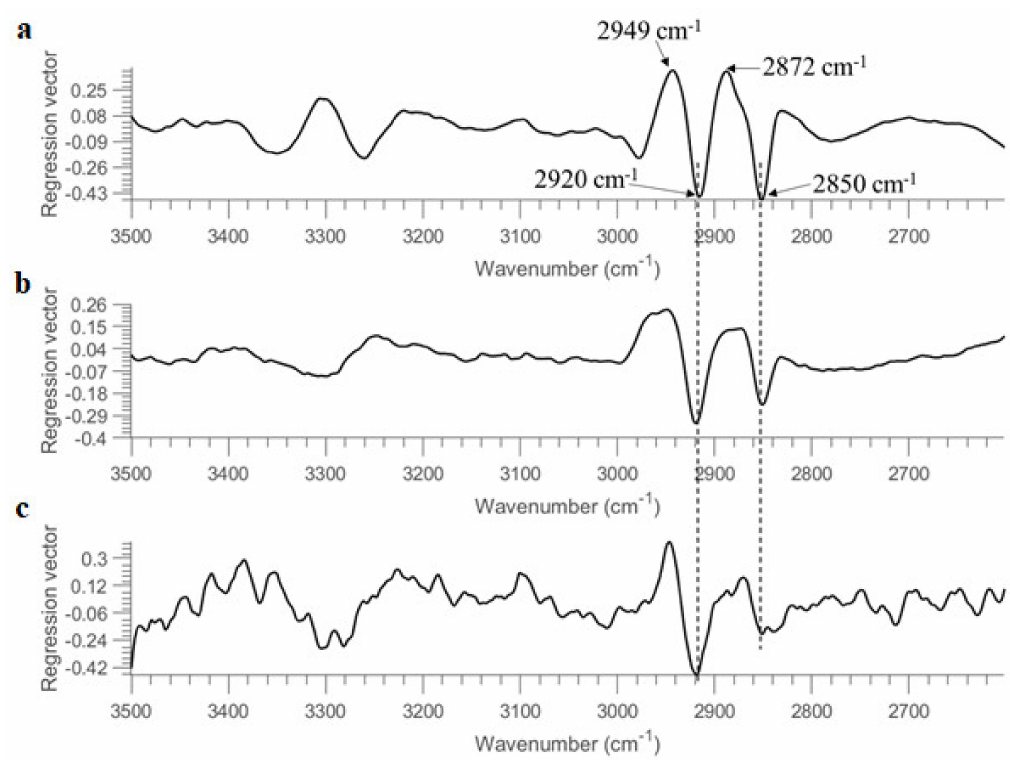
Figure 6. Regression vectors of PLSDA models (using 3500–2600 cm − 1 range after SNV pre-treatment) built from ( a ) 10 OD,